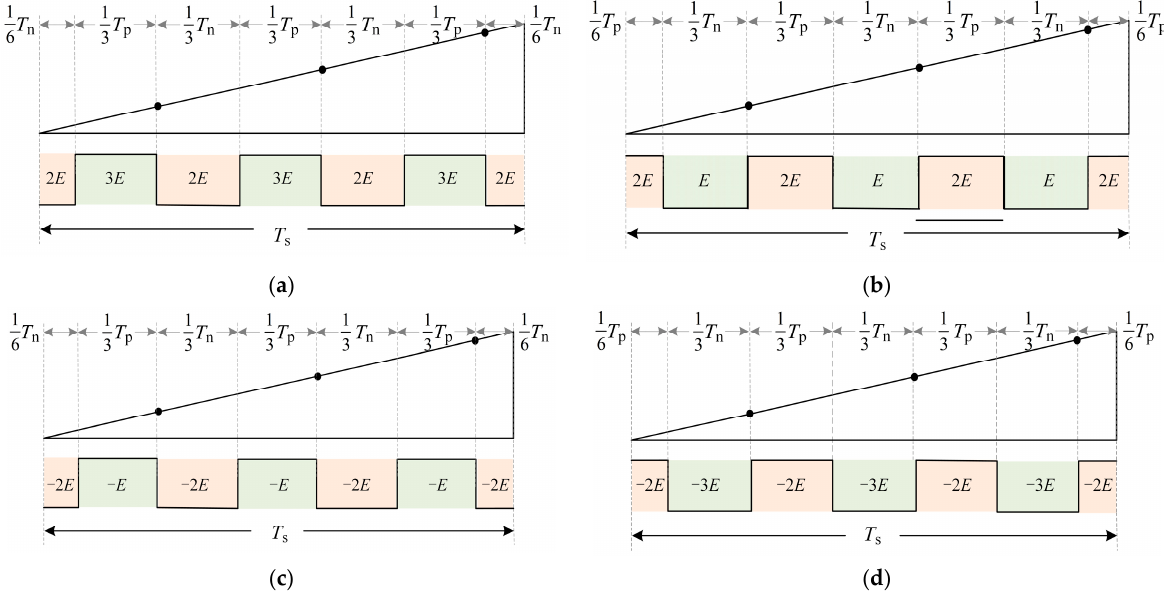
Figure 5. The switching sequences that contain the 2 E , − 2 E voltage vector. ( a ) N = 3; ( b ) N = 1; ( c ) N = − 1; ( d ) N = −